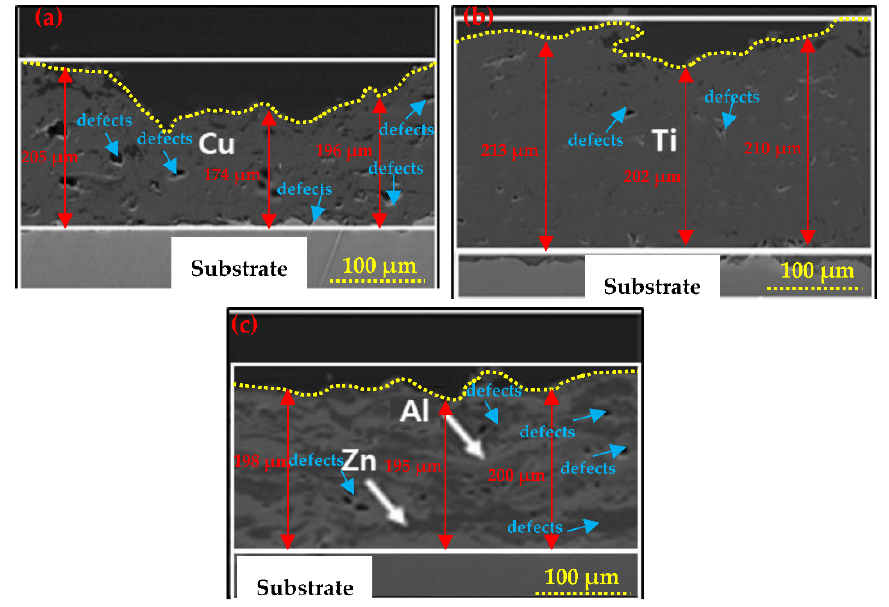
Figure 2. SEM of ( a ) Cu, ( b ) Ti, and ( c ) 85Zn-15Al coatings at 1000× and 10,000× (inset SEM im- ages) deposited on the concrete surface.